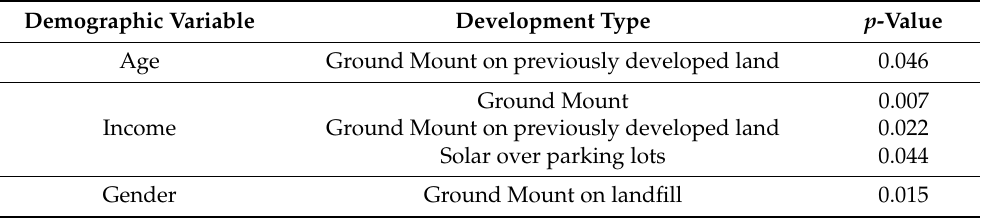
Table 3. Comparison of Means for Development